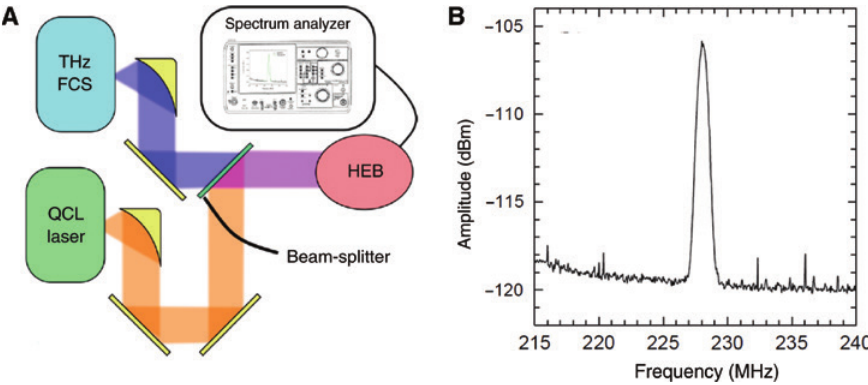
Figure 17: Experimental setup for THz linewidth measurement. (A) Schematic diagram of the heterodyne-detection measurement setup. (B) Typical beat-note spectrum obtained from our DFG-QCL for the integration time of 2 ms